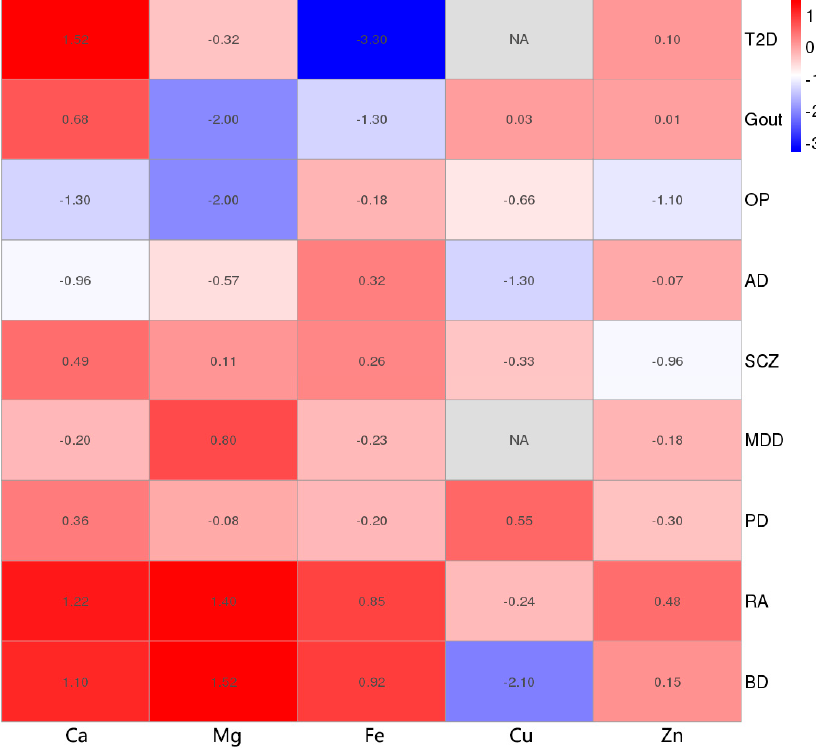
Figure 3. MR estimates of the causality between minerals and diseases in the summary heat map. Red represents a positive correlation, blue represents a negative correlation, and the shade of color represents the significance of the degree of causality. We took the logarithm of the predicted causal effect P value, and determined the directionality of the causal relationship according to the positive and negative of the BETA value, with -log (0.05) = 1.30 as the threshold. If the absolute value of each box value is greater than the threshold, it is considered to have a significant causal relationship. The abscissa indicates the five mineral elements, Ca, Mg, Fe, Cu and Zn, and the ordinate indicates the nine diseases. NA indicates a missing value.